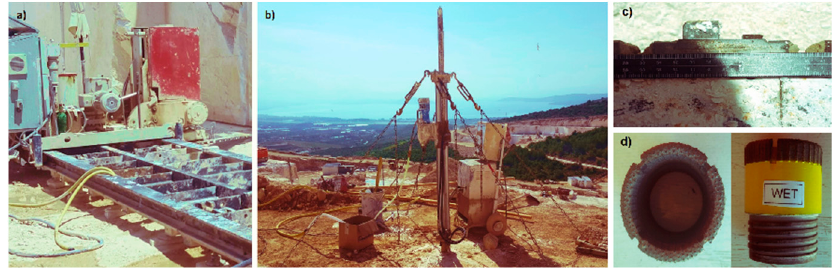
Figure 1. ( a ) Chain saw; ( b ) Hydraulic rotary drill; ( c ) Cutting tool; ( d ) Natural diamond core bit.